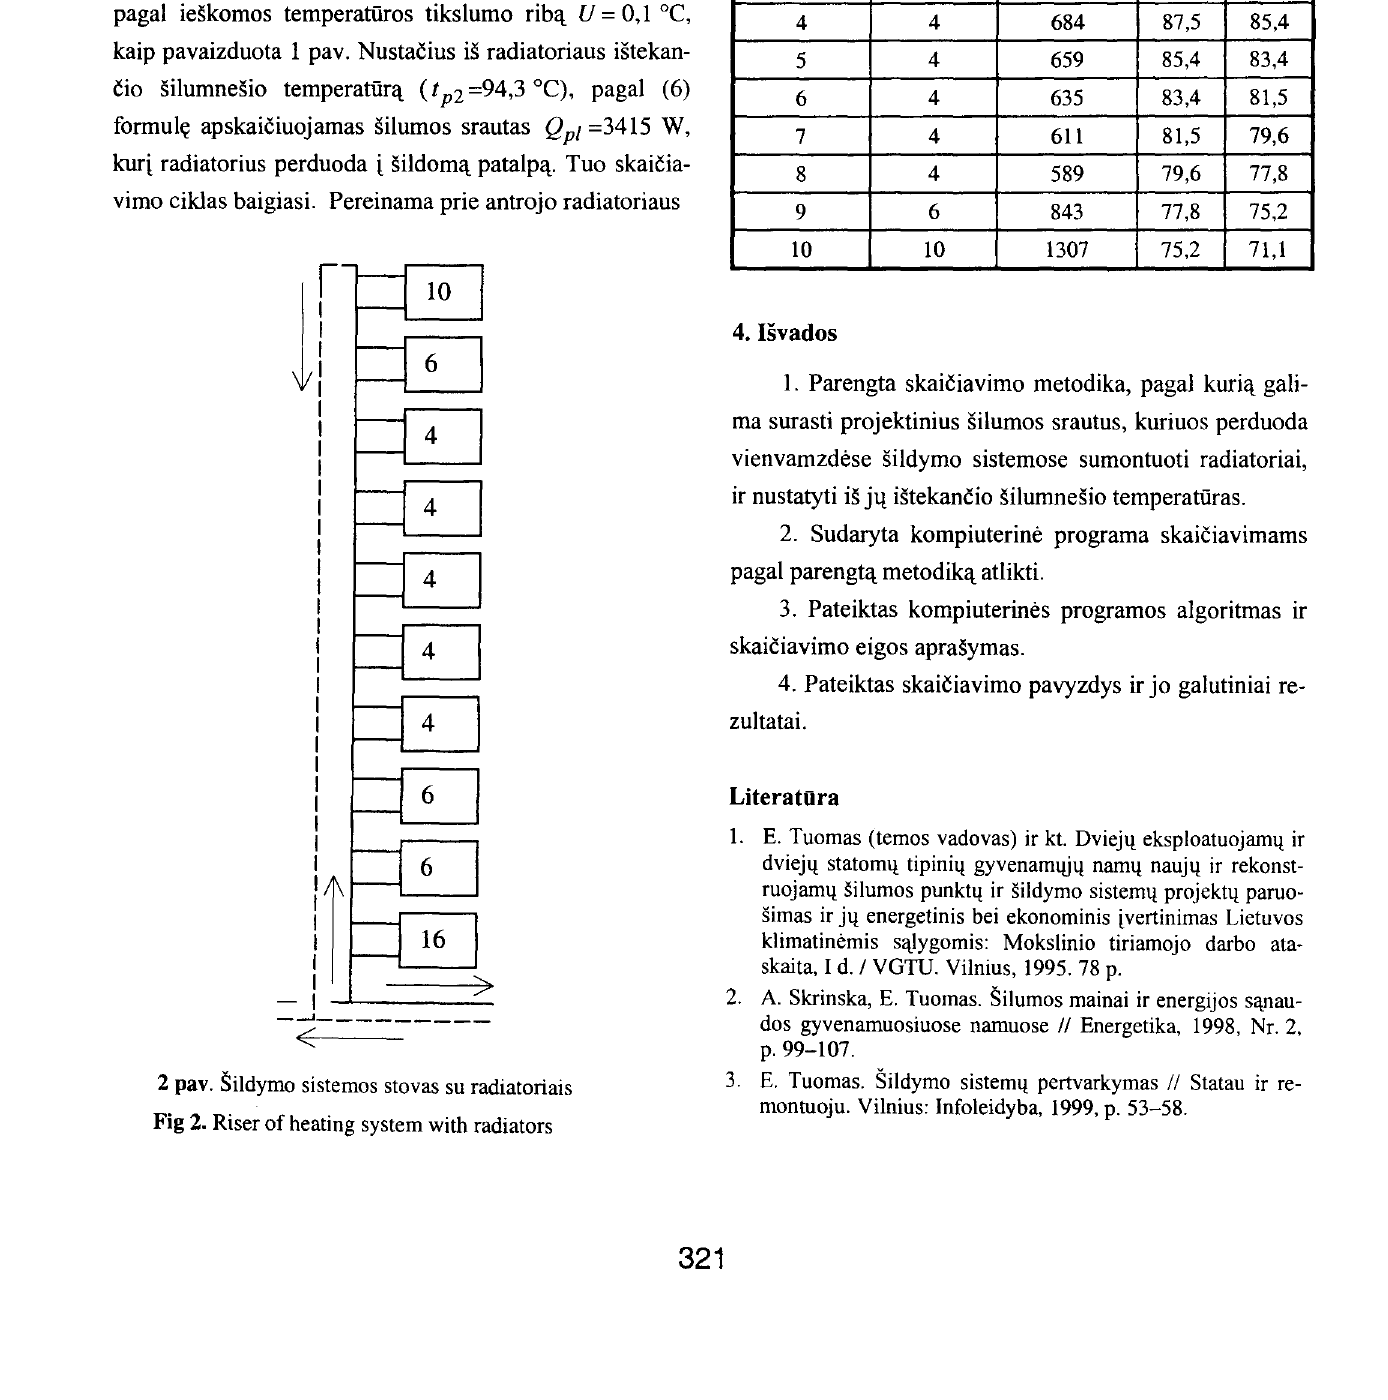
Fig 2. Riser of heating system with